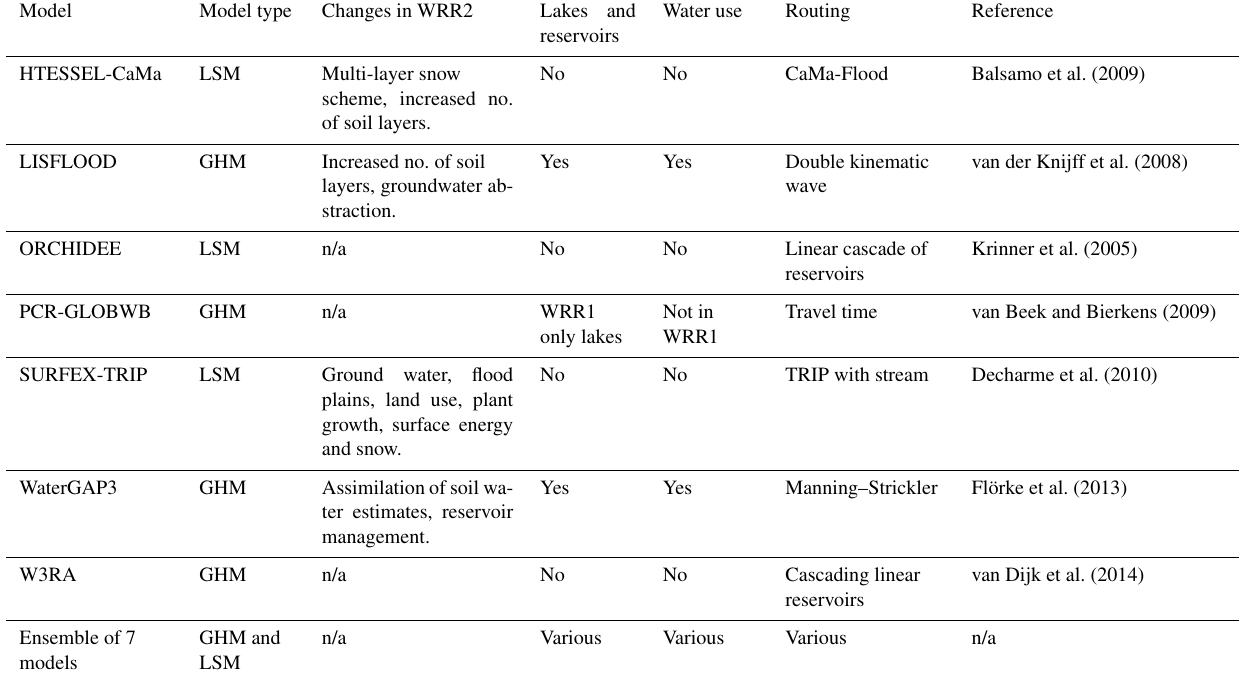
Table 1. Overview of the seven global models in the Water Resources Reanalysis dataset that include daily river discharges. n/a means not